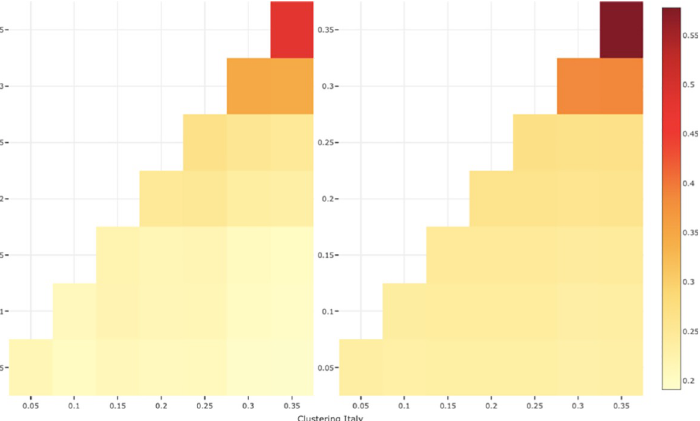
Fig 6. Effect of clustering on the difference between Italy and Germany. Average differences in the proportion of cases between an Italian network (age assortativity = 0.40 and degree distribution of Italy) and a German network (age assortativity = 0.44 and degree distribution of Germany), for 1,250 replications for each cell (25 networks � 50 simulations of the diffusion of the virus, starting from different originally infected nodes), for different values of clustering. Dyadic contagion probability p = 0.05. Left panel represents the difference in the proportion of cases among the elderly (nodes aged over 65); right panel: for the full population.